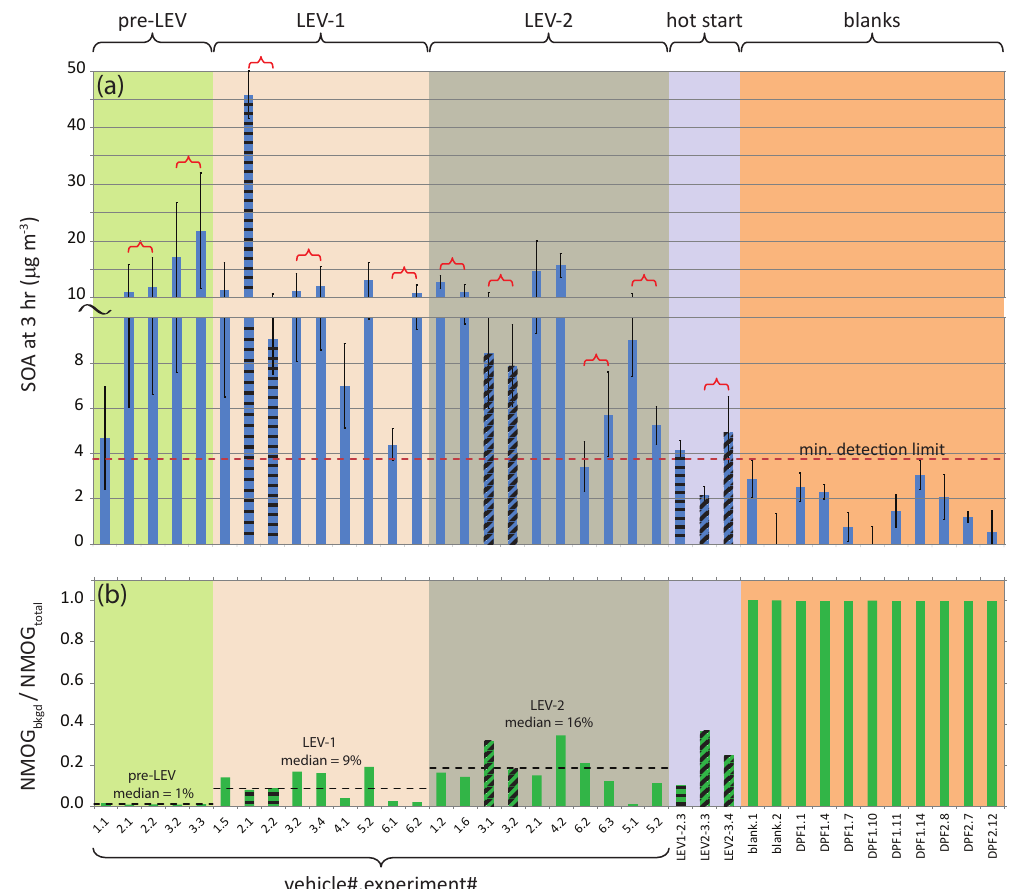
Fig. 5. (a) Measured wall-loss-corrected SOA concentration (assuming no blank correction) after 3h of photooxidation and (b) fractional contribution of background NMOG to smog chamber. Blue bars in (a) show the average SOA based on the two different wall-loss correction methods, and the range of these estimates is shown by the error bars. The red braces in (a) indicate duplicate experiments. Hot-start and normal UC driving cycle experiments with two vehicles (LEV1-2 and LEV2-3) are denoted by the horizontal and diagonal black lines inside of the bars, respectively. (SOA from the pre-LEV hot-start experiment was not measured due to instrument failure.) The horizontal dashed red line in (a) indicates the minimum SOA detectible by the instruments. “Blanks” included two dynamic blanks and nine experiments with diesel-particulate-filter-equipped heavy-duty diesel trucks (Gordon et al., 2013a). The dashed black lines in (b) indicate the median values of NMOG bkgd /NMOG total for the three LEV